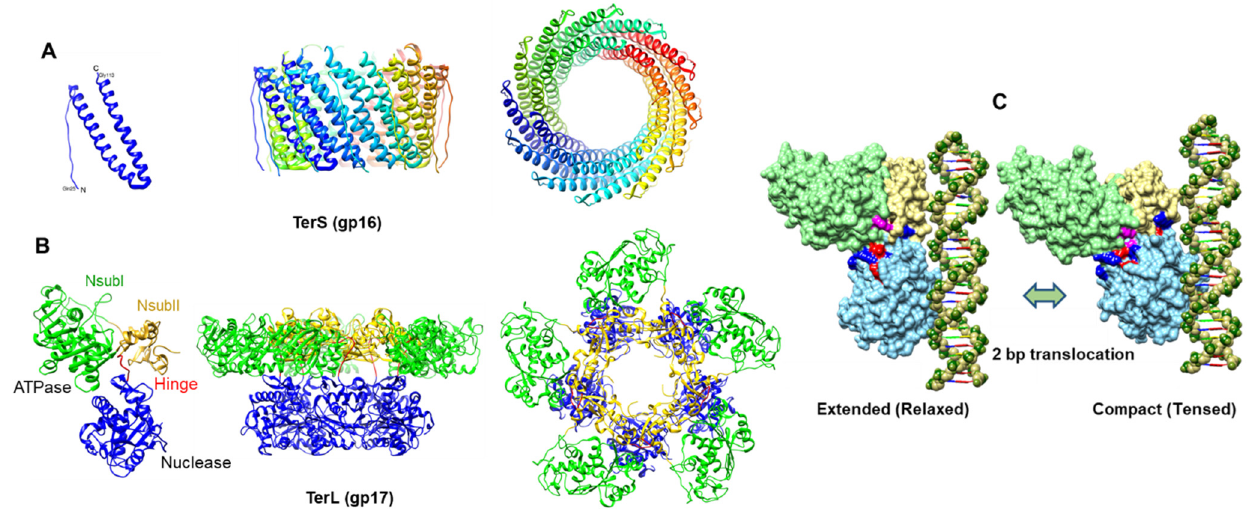
Figure 6. Structures of the phage T4 TerS and TerL terminase/packaging proteins. ( A ) Structures of gp16 TerS oligomerization domain from the T4-related phage 44rr2. A gp16 monomer and the side and top views of the 12-mer are shown (PDB ID: 3TXS). ( B ) Structural models of full-length gp17 TerL; monomer (PDB ID: 3CPE) and side and top views of pentameric motor (PDB ID: 3EZK) derived from the cryo-EM density. ( C ) Structural models of extended (relaxed) and compact (tensed) conformational states of TerL, showing ion pairs at the interface of ATPase and nuclease domains. Acidic residues are shown in red spheres, basic residues in blue spheres, and hydrophobic/uncharged residues in purple spheres.